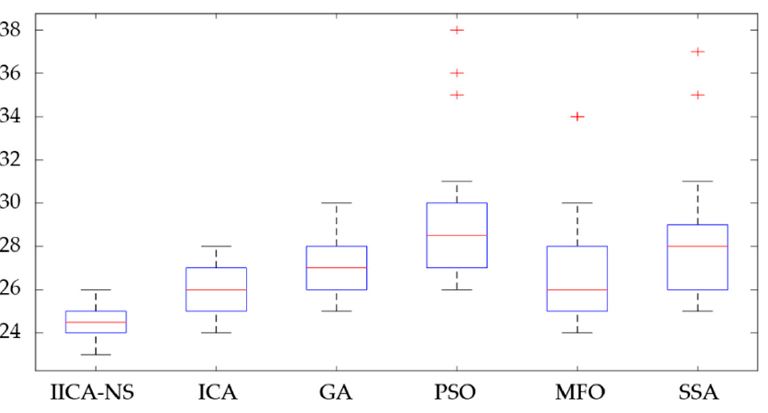
Figure 8. Box-plot of four algorithms for large-scale TPS8.